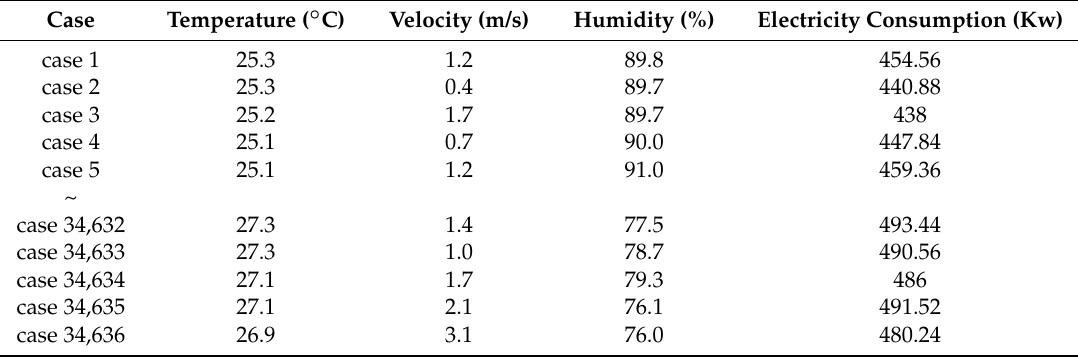
Table 2. Training data and validation data for Genetic Algorithm-Support Vector Machine